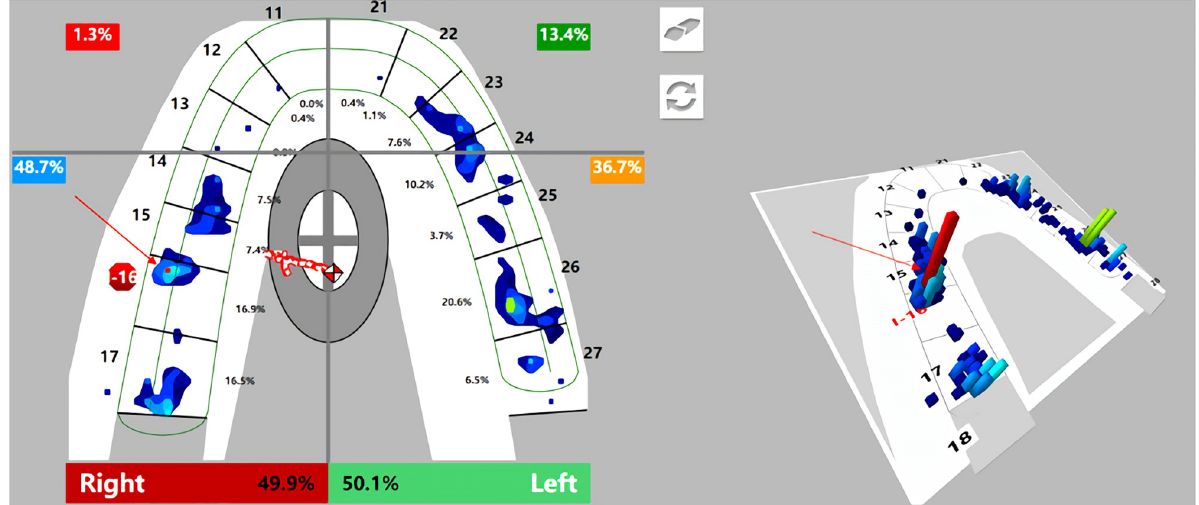
Fig 3. High density of the bite force on implant crown (16) from T-scan (inserted immediately). Red arrows indicate 2D and 3D images of the high density of occlusal contact. https://doi.org/10.1371/journal.pone.0252191.g003 PLOS ONE | https://doi.org/10.1371/journal.pone.0252191 July 2,